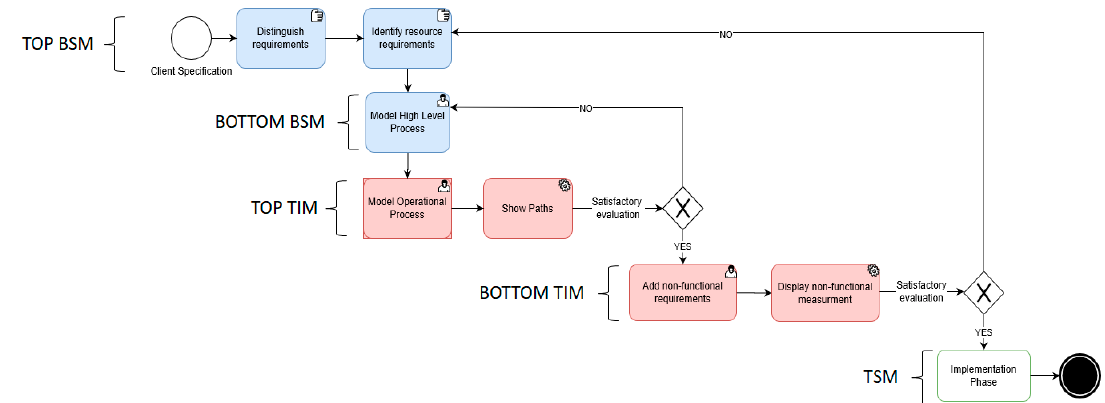
Figure 2. Modeling and simulation methodology based on MDSEA.